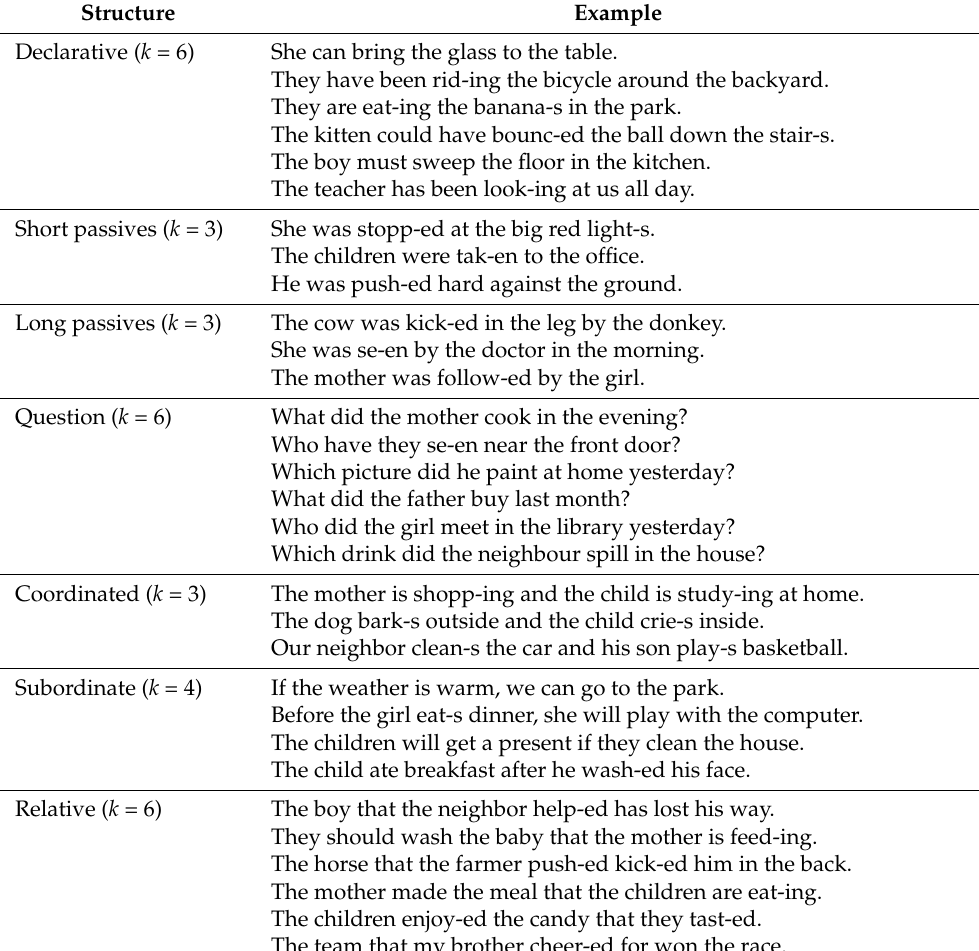
Table A1. Stimuli used in English